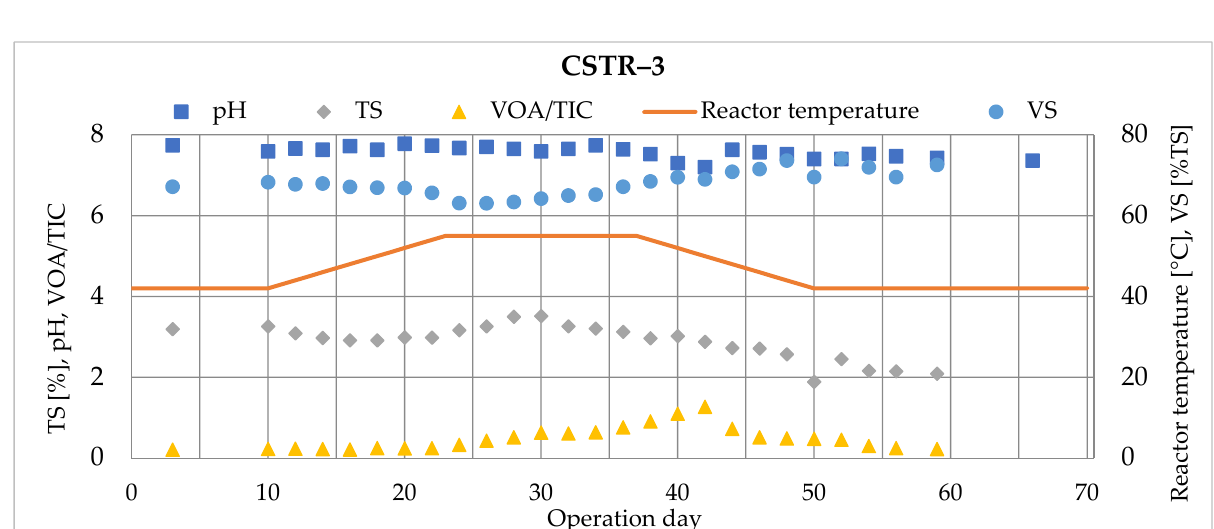
Figure 12. Laboratory analyses results of CSTR-3.